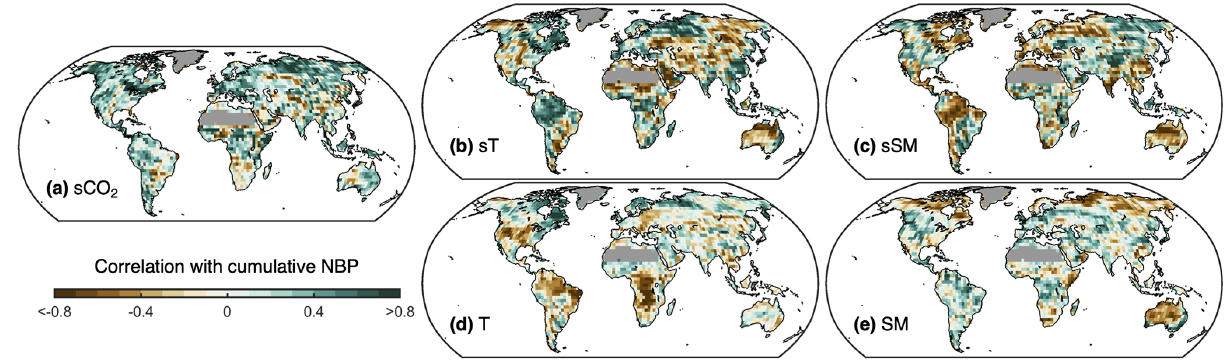
Figure 5. Influence of model characteristics on projected cumulative NBP. Pearson correlation at each grid cell between cumulative NBP projected by each Earth system model and their (a) sensitivity to CO 2 concentration (sCO 2 ), (b) sensitivity to temperature (sT), (c) sensitivity to soil moisture (sSM), (d) long-term warm-season average temperature ( T ), and (e) long-term warm-season average soil moisture (SM). For panels (b) and (c) , sT and sSM correspond either to the covariance or to the correlation of detrended annual anomalies of NBP with T and SM, depending on which has the strongest absolute correlation with projected cumulative NBP. Regions with 2015–2100 average GPP below 100gCm 2 yr − 1 are